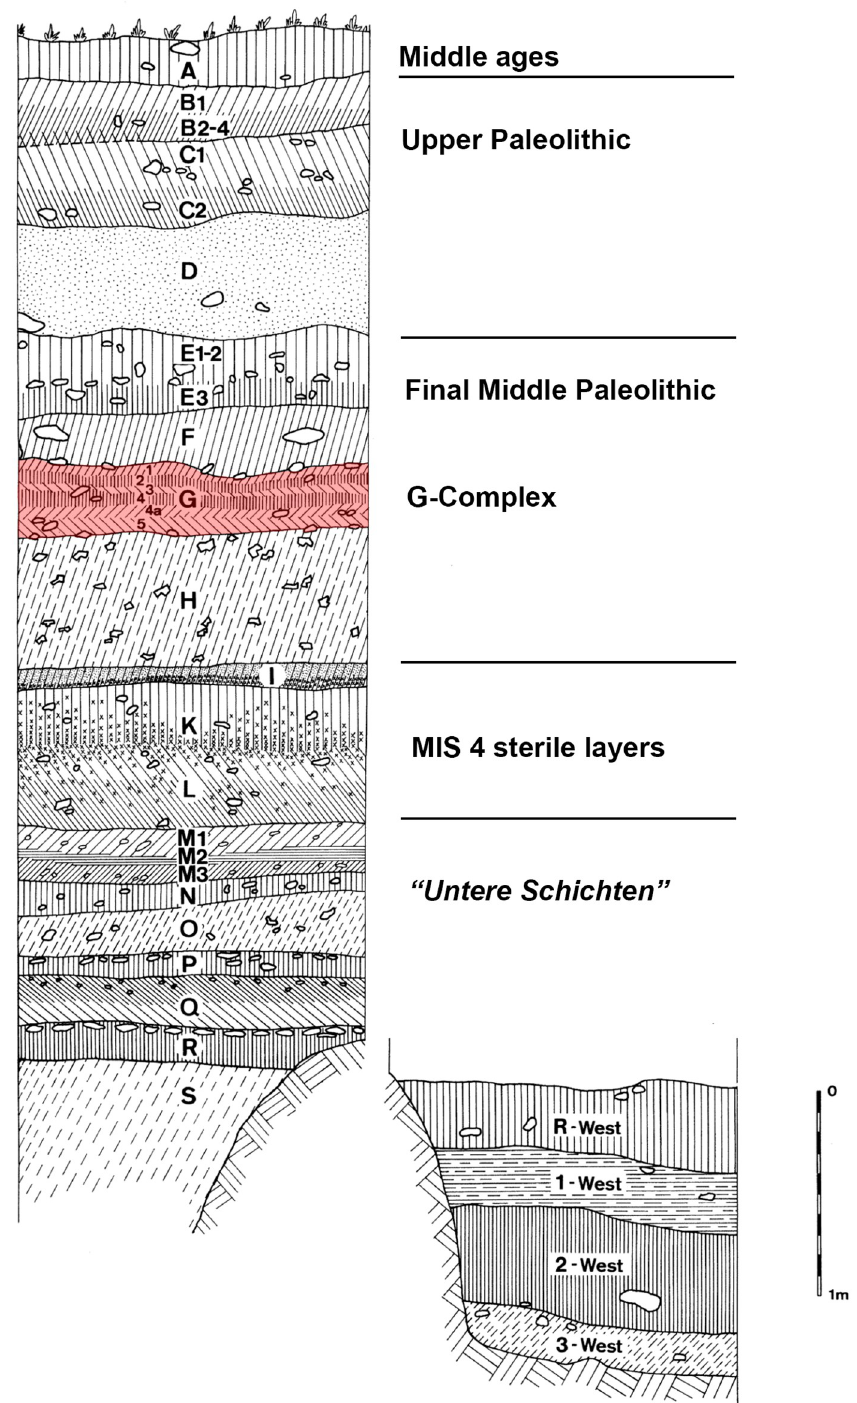
Fig 2. Stratigraphical sequence of Sesselfelsgrotte: G-Complex layers are highlighted. Modified from Freund, 1984.